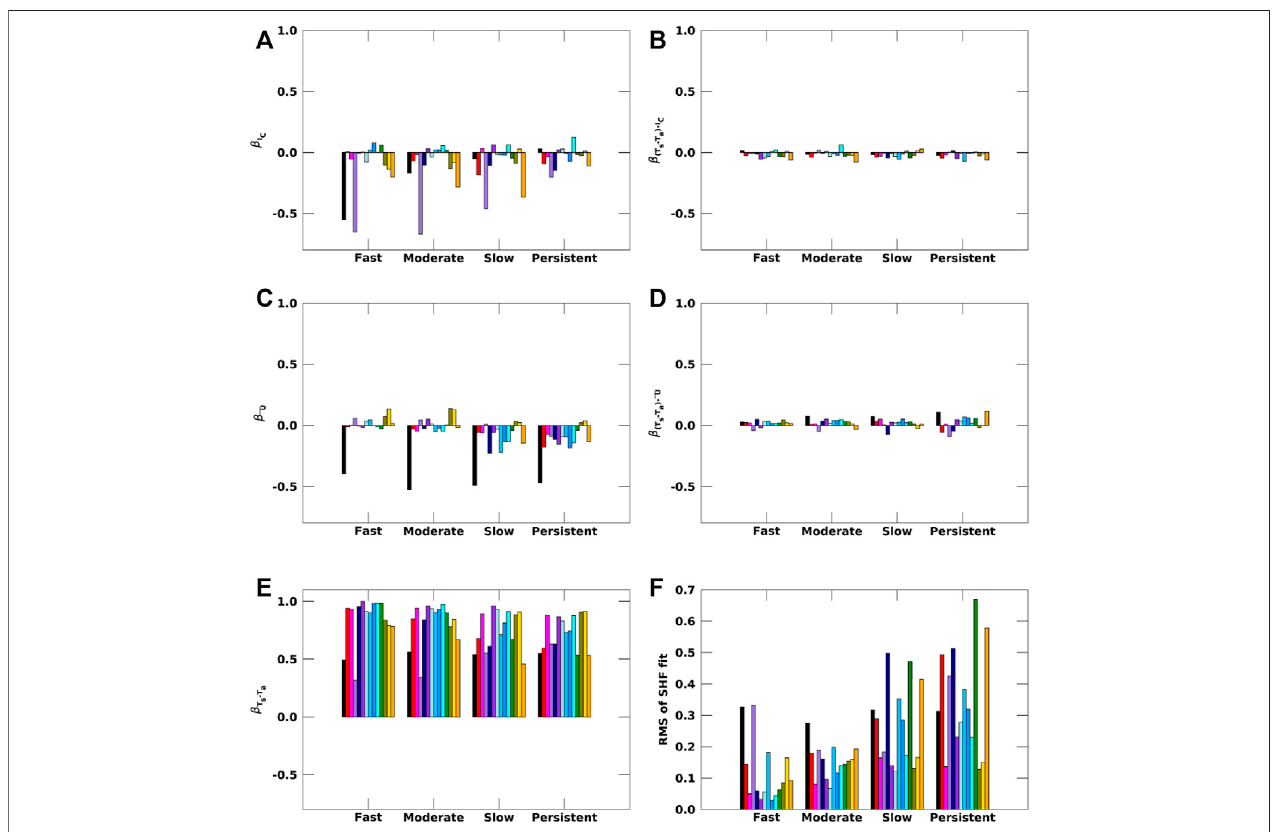
FIGURE8| Slopesobtainedfromthemulti-linearregressiononSHF (A – E) forobservations(black)andCMIP6models(colored)forthefouricelossregimesduring Arctic winter (ONDJ). RMS for the fi t is shown in (F) .